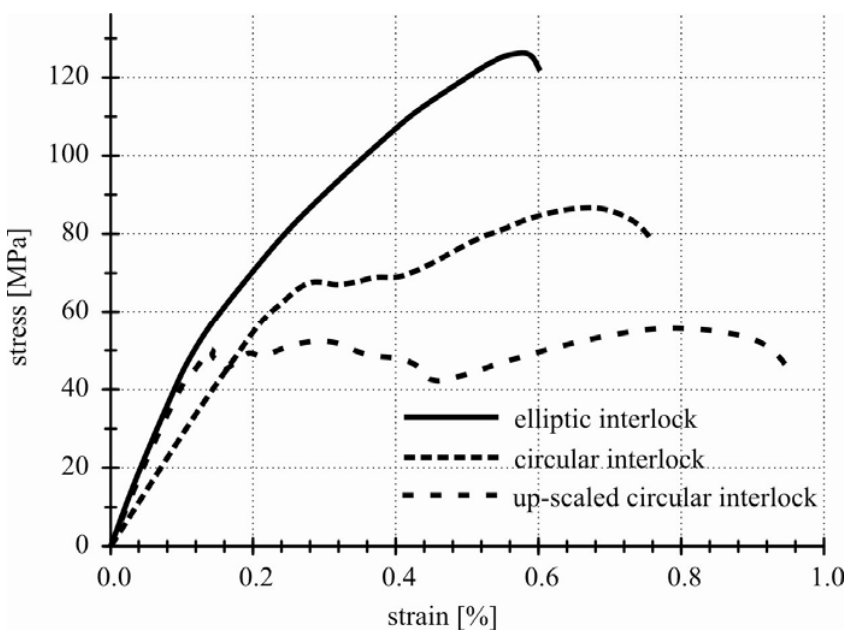
Figure 10. Stress-strain diagram of different interlock